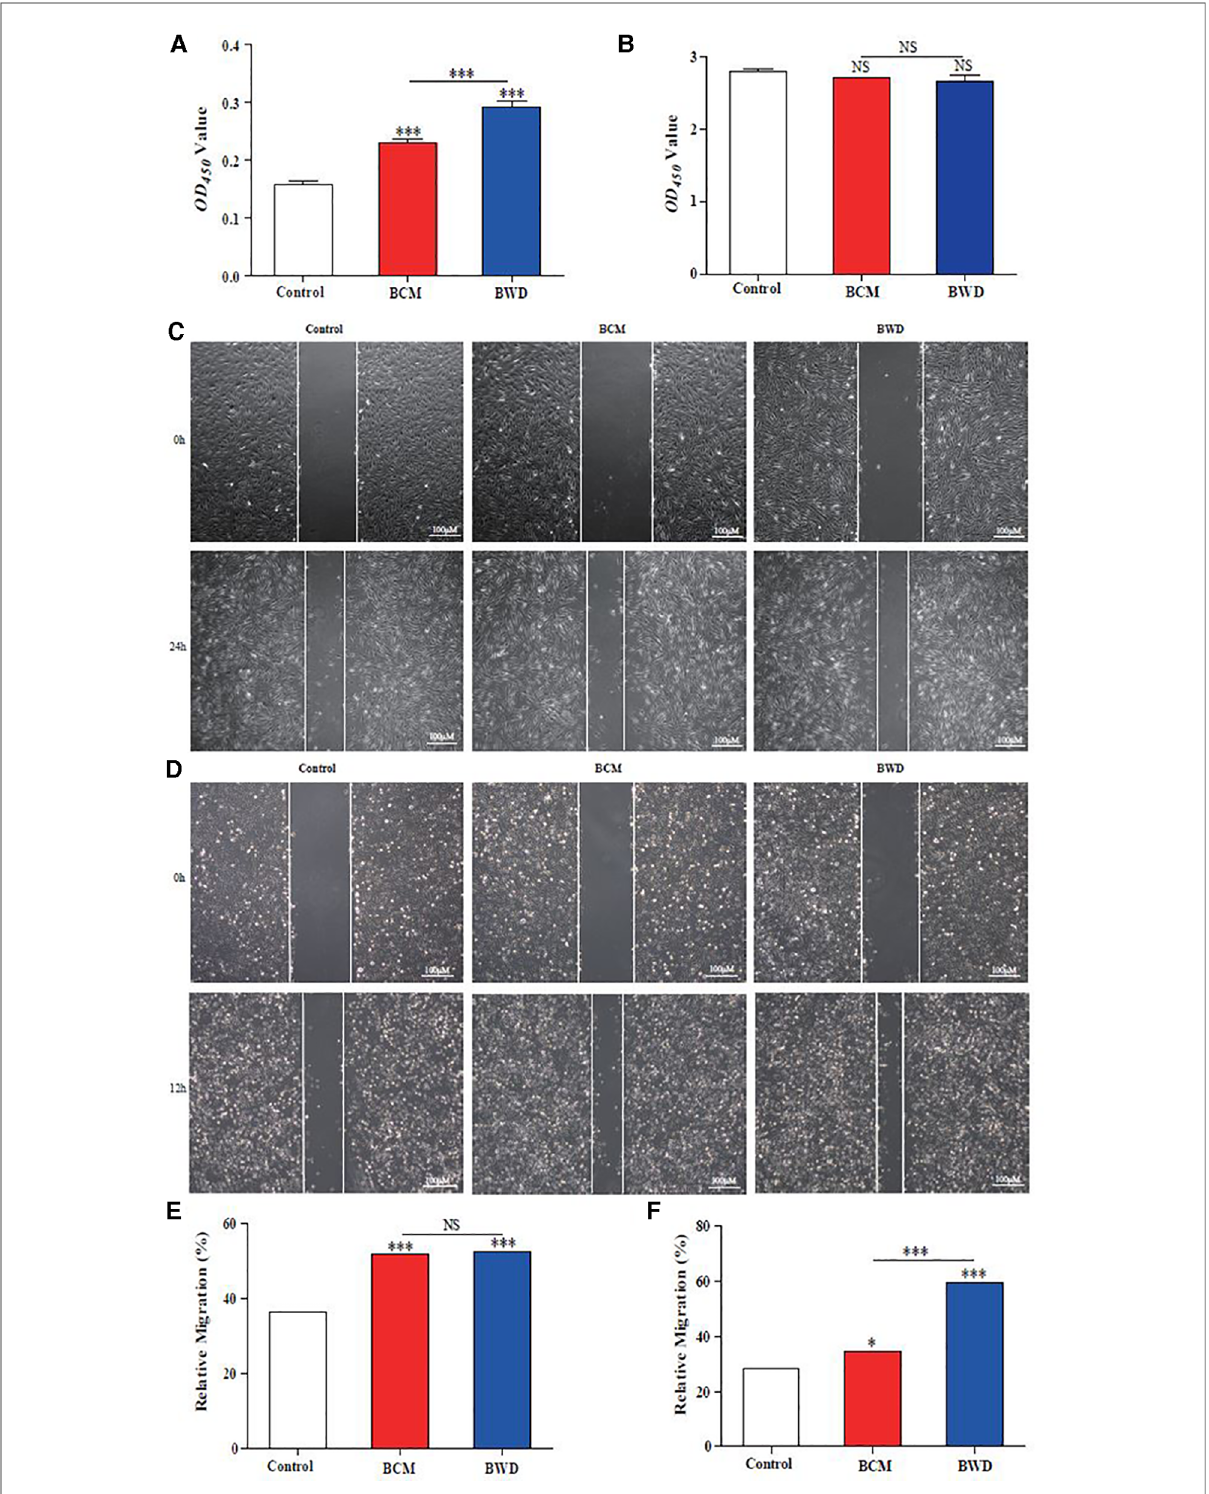
FIGURE 4 Proliferation and migration of HDFs and HuVECs. ( A ) CCK8 assay for the proliferation of HDFs. ( B ) CCK8 assay to detect the proliferation of HuVECs. ( C,E ) Scratch-wound assay for HDF migration. ( D,F ) Scratch-wound assay for HuVEC migration. Control, saline gauze; BCM, bacterial cellulose membrane; BWD, bioactive wound dressing; bar scales=100 μ M. Error bars represent SEM ( n =3), * P ≤ 0.05, *** P ≤ 0.001, and NS indicated no statistical